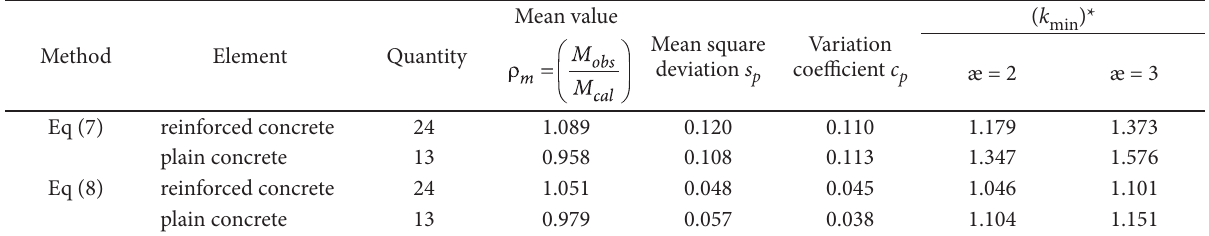
Fig. 4. The algorithm of evaluating the bearing capacity of the reinforced concrete elements of circular cross-section